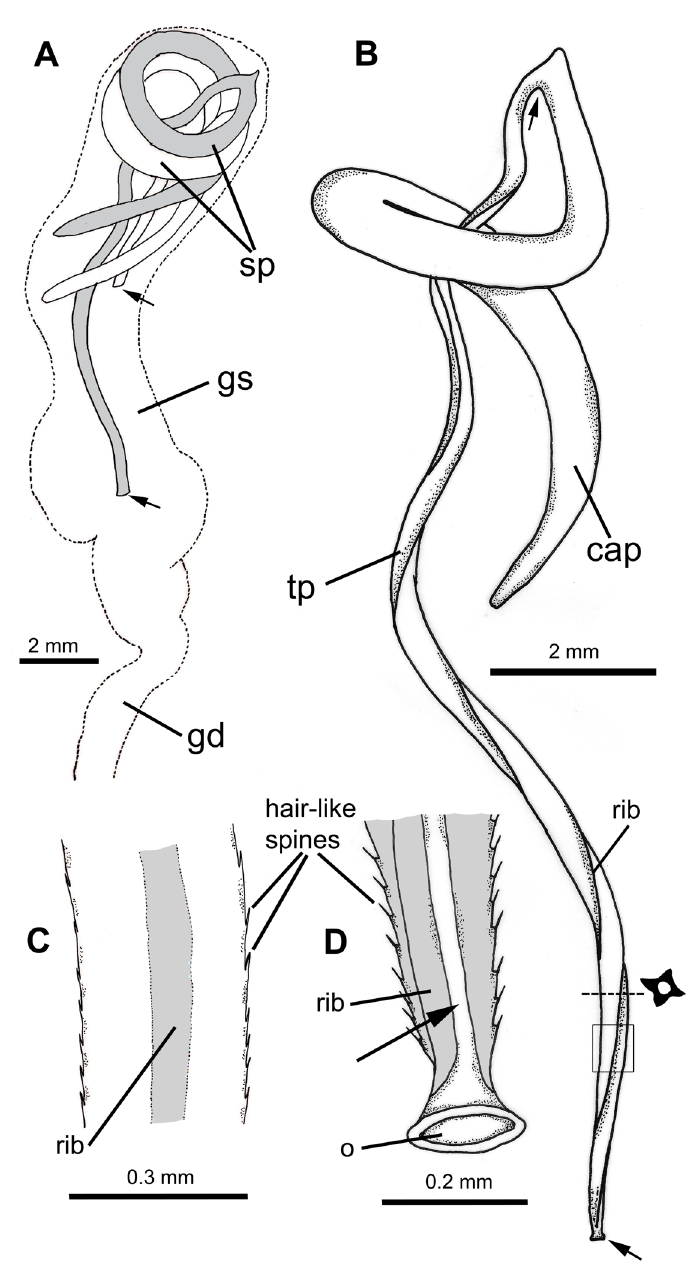
Fig. 11. Spermatophore of Varadia amboliensis Bhosale, Thackeray, Muley & Raheem gen. et sp. nov. A . Fragments of two spermatophores (part of the tail-pipe is missing in both), as found in situ in the gametolytic sac of the paratype BNHS GAS 125. B–D . Morphology of the fully-intact spermatophore found in the gametolytic sac of the paratype ZSI Moll/1820. B . The upper arrow indicates the U-shaped bend at the junction of the capsule and tail-pipe, and the lower arrow shows the funnel-like opening at the tip of the tail-pipe. Also shown is the cross section of the spermatophore (indicated by the dotted line) close to the tip of the tail-pipe; note the hollow central area. C . Detail of a small section of the tail- pipe (indicated by rectangle in B), showing one of the four longitudinal ribs and the hair-like spines on the spermatophore surface. D . Detail of tip of tail-pipe, showing the funnel-like opening that leads into the hollow central area (shown by arrow). Note the hair-like spines. Abbreviations: cap = capsule; gd = gametolytic duct; gs = gametolytic sac; o = opening at tip of tail-pipe; sp = spermatophore; tp =